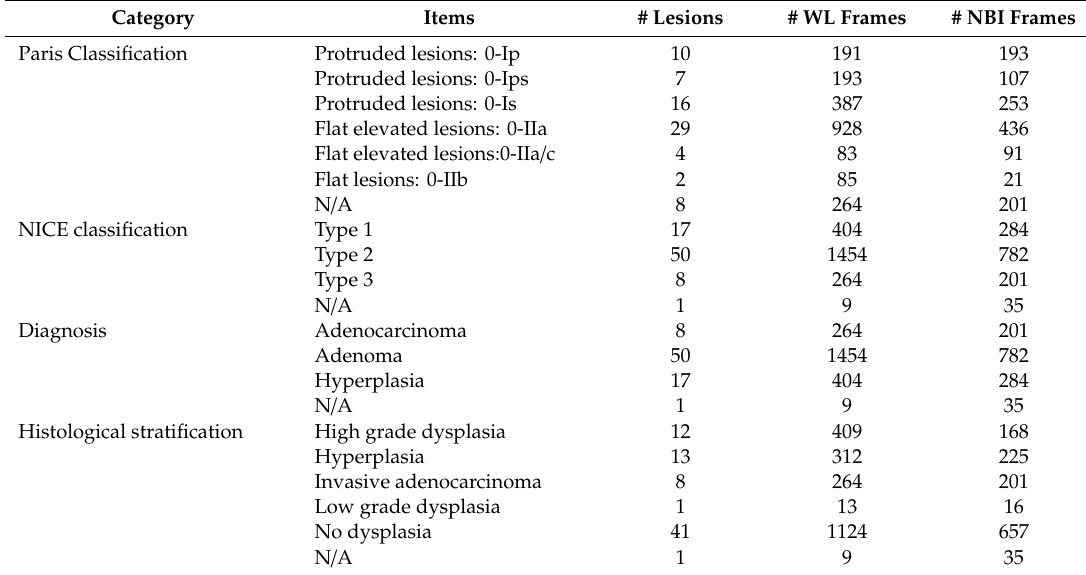
Table 1. Lesions and frames in the PICCOLO dataset according to clinical metadata.